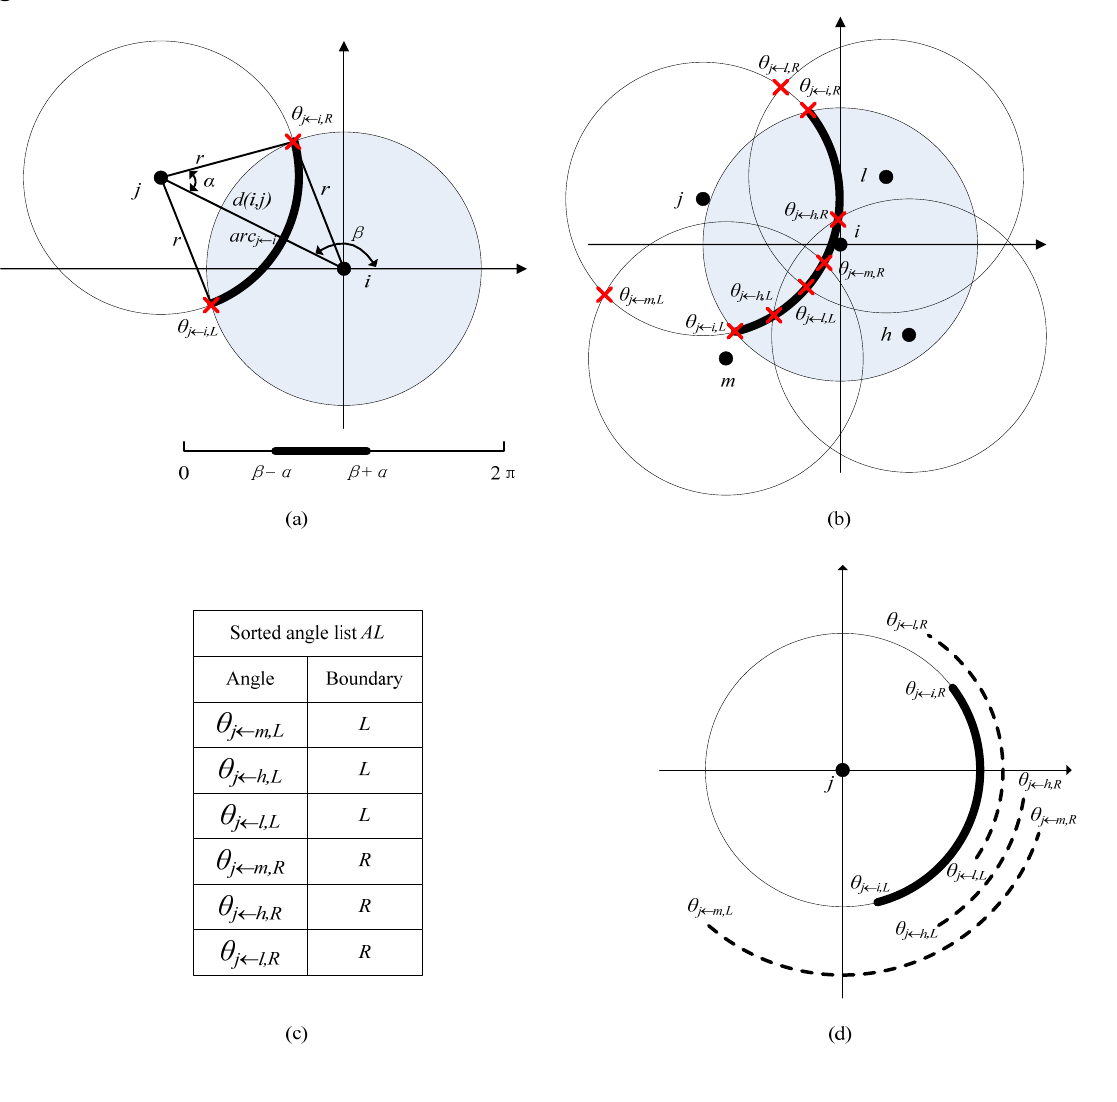
Figure 4. Calculation of the perimeter coverage degree of an arc segment in the ERPC